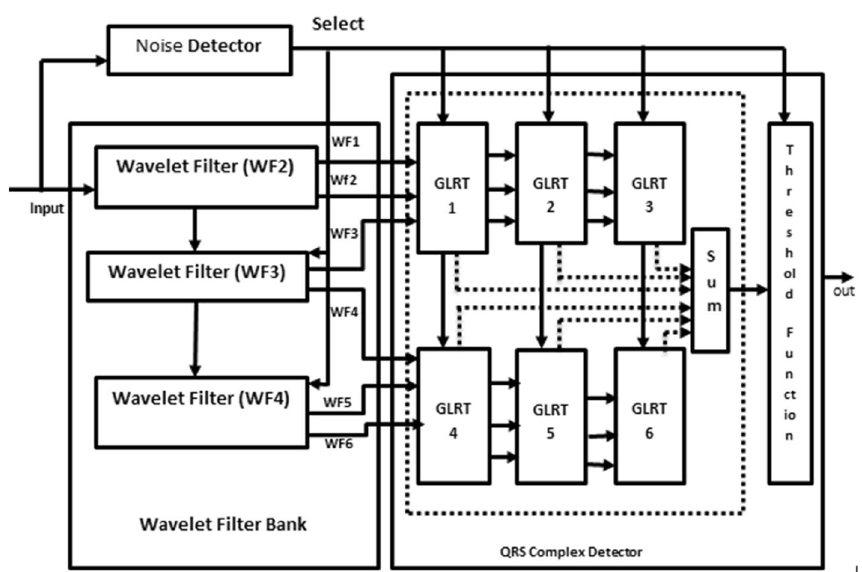
Figure 2. Block diagram of conventional undecimator based ECG detector 4